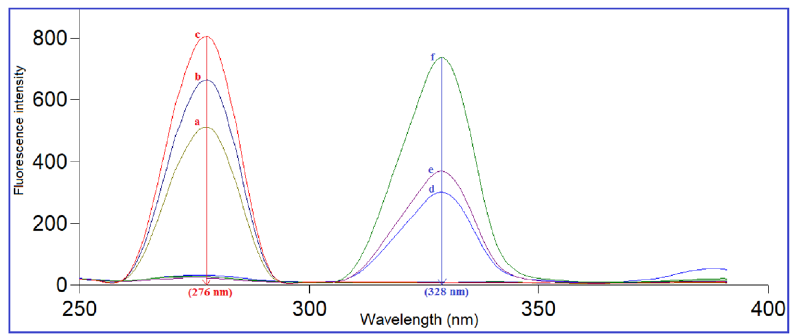
Figure 3. Synchronous fluorescence spectra of (1) a-c, VFX (600.0, 800.0, and 1000.0 ng/mL) (2) d-f, AGM (80.0, 100.0, and 200.0 ng/mL) at Δλ = 20